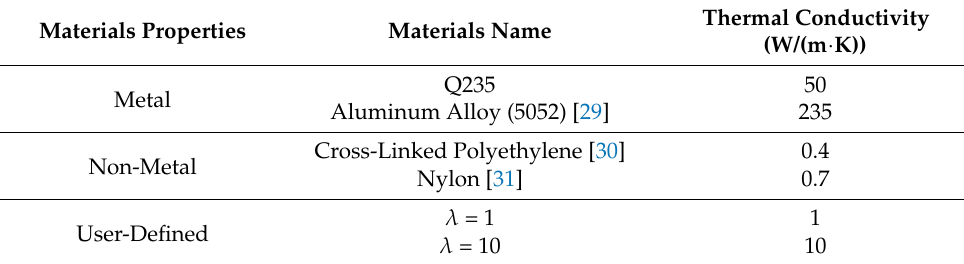
Table 3. Hydraulic tank material and its thermal